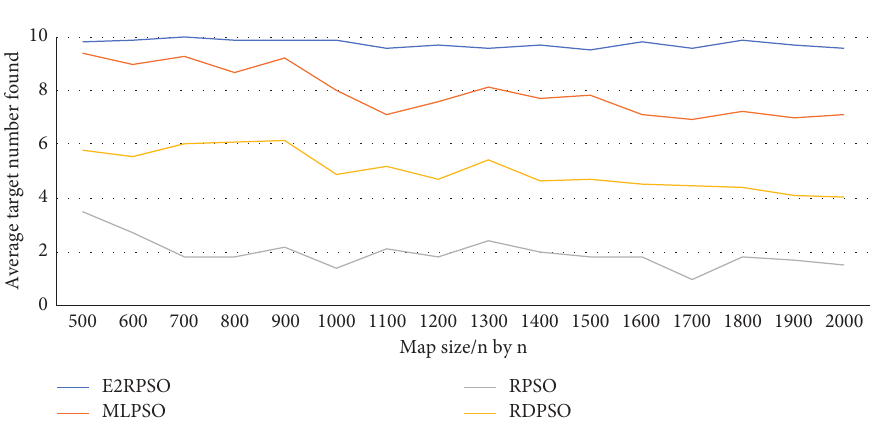
Figure 6: Comparison of average targets found under different environment